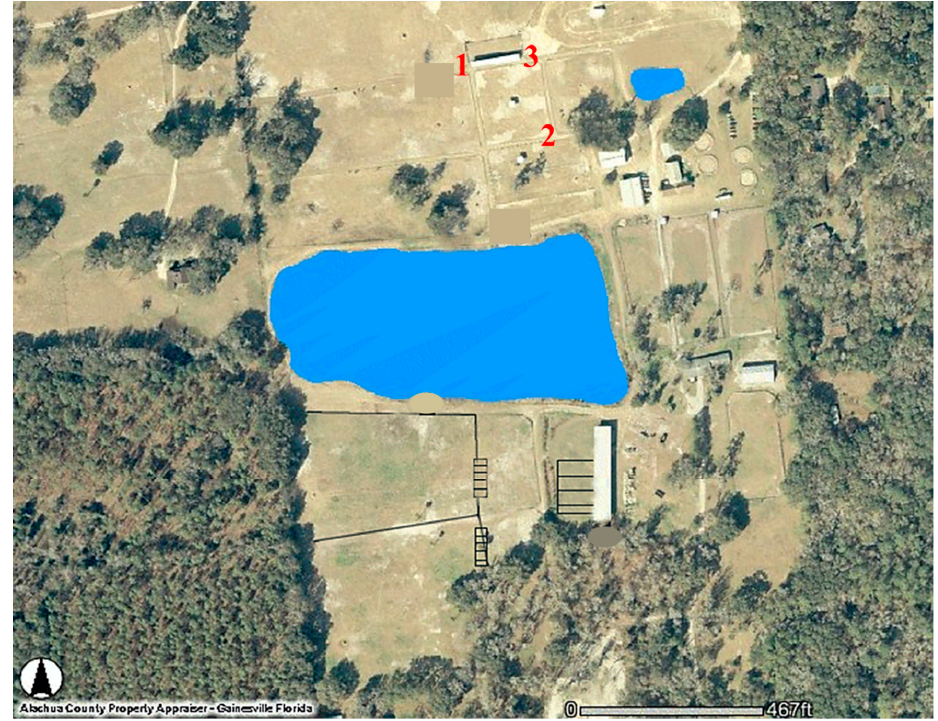
Figure 1. UF Horse Teaching Unit (HTU) showing the placement of the 3 Centers for Disease Control (CDC) 1012 traps near a horse barn in the Location Profile study.